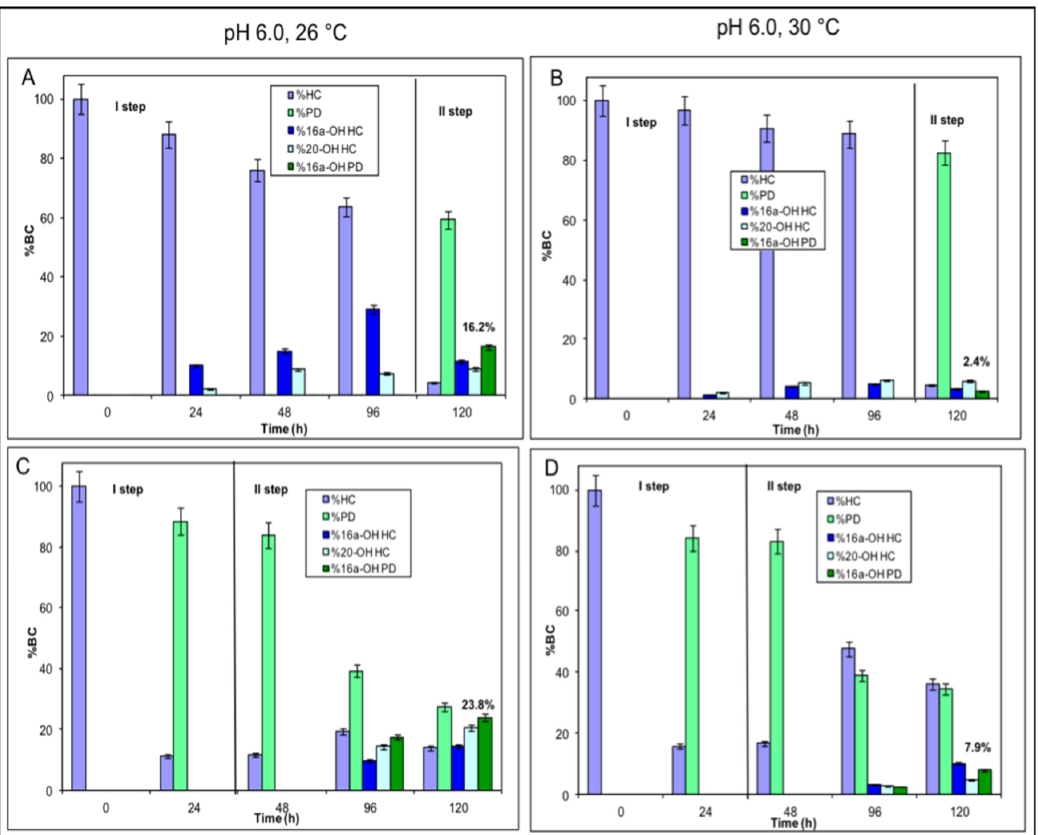
Figure 5. Bioconversion of 0.1 g·L − 1 HC into different products in whole cell experiments at pH 6.0 and 26 or at 30 °C obtained by employing S. roseochromogenes first and then A. simplex , respectively ( A , B ) or A. simplex first, and then S. roseochromogenes , respectively ( C , D ). In the graphs, a black line separates the two steps of the experiments. The 16 α -OH-prednisolone percentages obtained are reported in